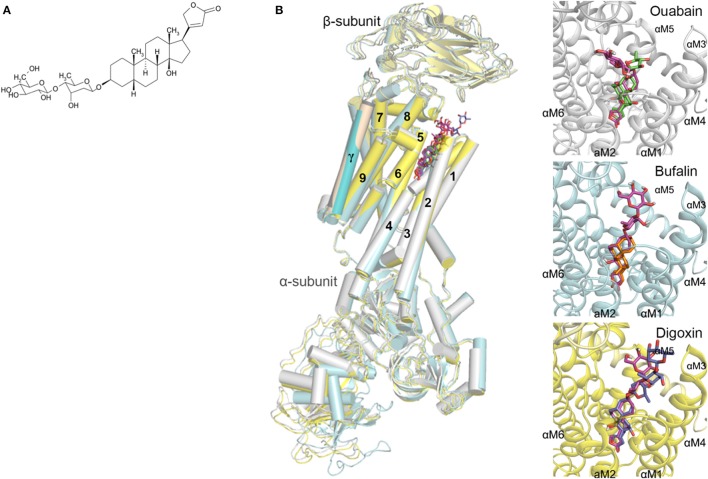
(A) Chemical structure of GEV; (B) Docking orientation of GEV in the crystal structures of the Na+/K+-ATPase (PDB ID: 4HYT, 4RES, 4RET) (Laursen et al., 2013, 2015). The Na+/K+-ATPase protein complexed with ouabain, bufalin, and digoxin is depicted as a cartoon colored in white, cyan, and yellow, respectively. The predicted docking modes of GEV are shown as stick models colored in magenta, and the coordinates of ouabain, bufalin, and digoxin are represented by green, orange, and blue sticks, respectively. The hydrogen and oxygen atoms are colored in white and red, respectively.